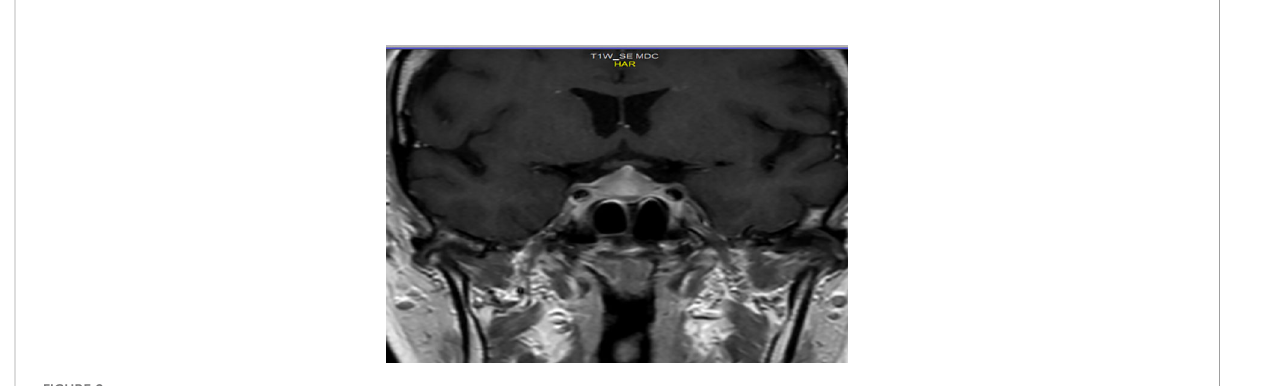
FIGURE 2 MRI: Radiological signs of hypophysitis. Inhomogeneous and enlarged appearance of the pituitary gland showing “ tent ” morphology due to tension of the meninges with thickening of the pituitary